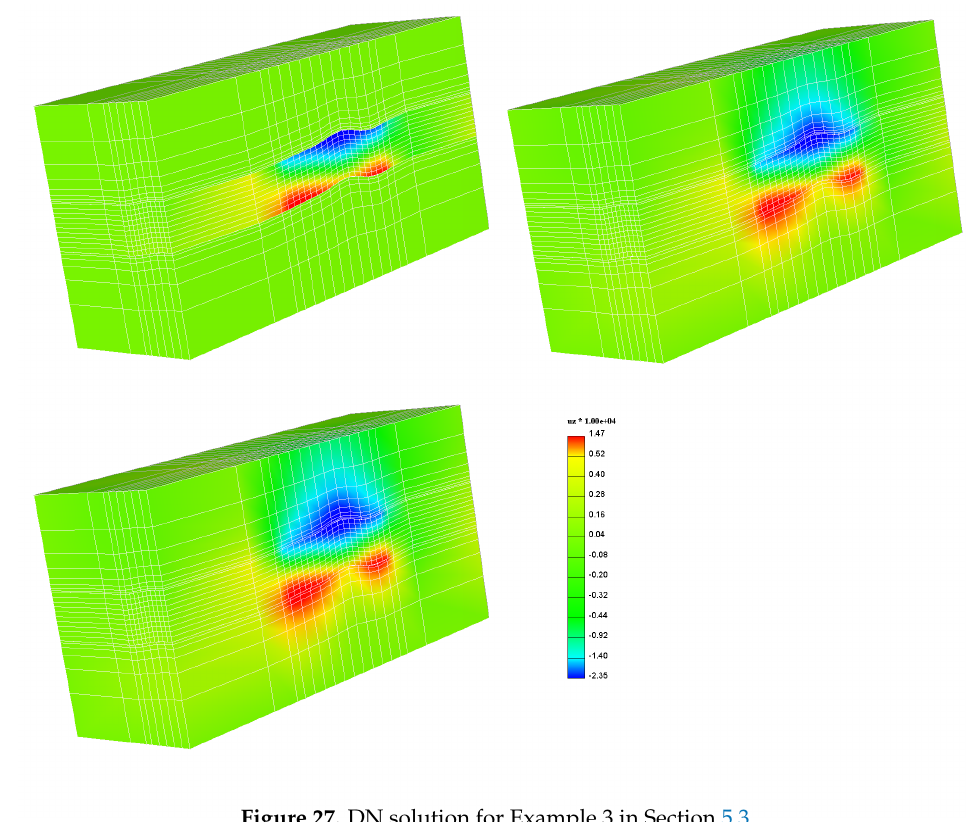
Figure 27. DN solution for Example 3 in Section 5.3.